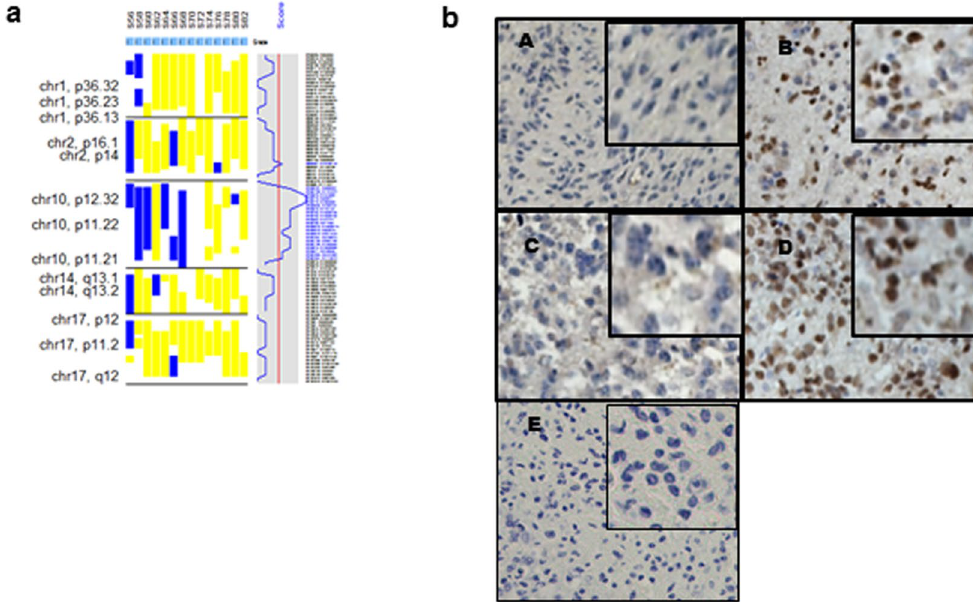
Figure 2. Decrease or loss of ZEB1 expression defines LOH. ( a ) Identification of LOH ( n = 14) with glioblastoma and matched controls within the ZEB1 locus (10p.11.2) LOH could be inferred in a retrospective SNP analysis of GBM patients indicated by colors yellow-no LOH, blue-LOH in 29% of patients. ( b ) Representative immunohistochemistry from tissue microarrays. Scale bar represents 100 μ